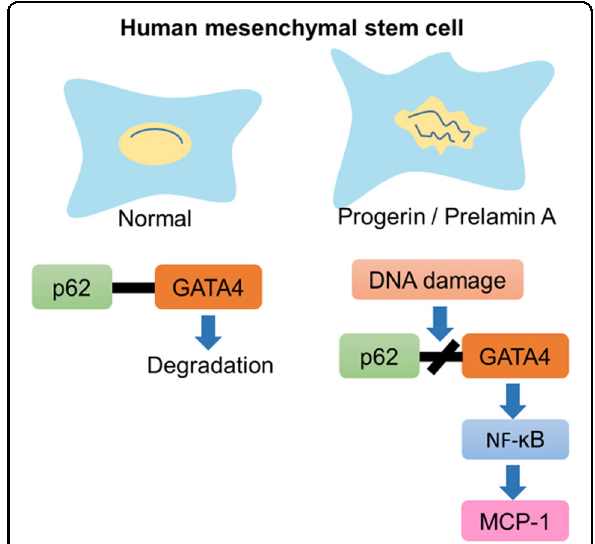
Fig. 6 Schematic representation of how GATA4 regulates senescence in hMSCs expressing progerin and prelamin A. Progerin or prelamin A expression induces GATA4 expression through an increased DNA damage response and decreased binding to p62. The NF- ĸ B pathway mediates GATA4-dependent MCP-1